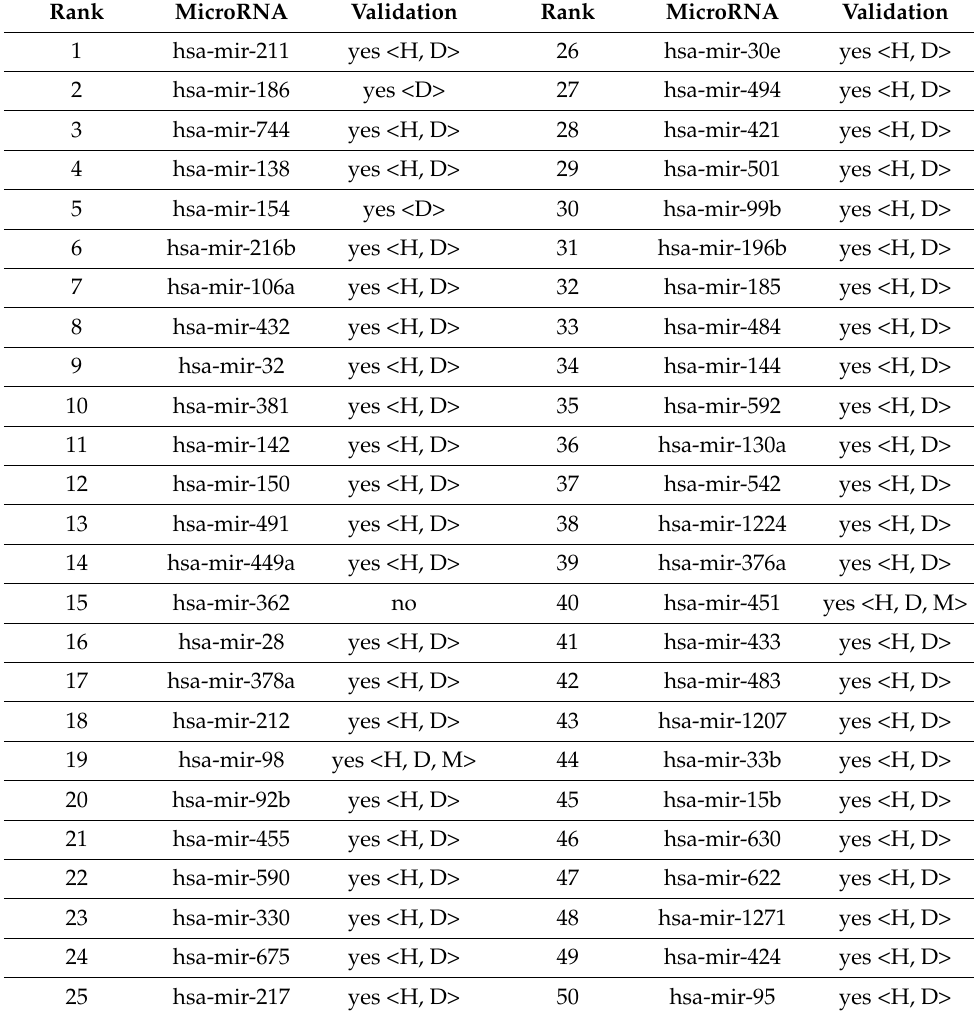
Table 4. Top 50 miRNAs predicted by HLGNN-MDA to be associated with breast cancer. Rank MicroRNA